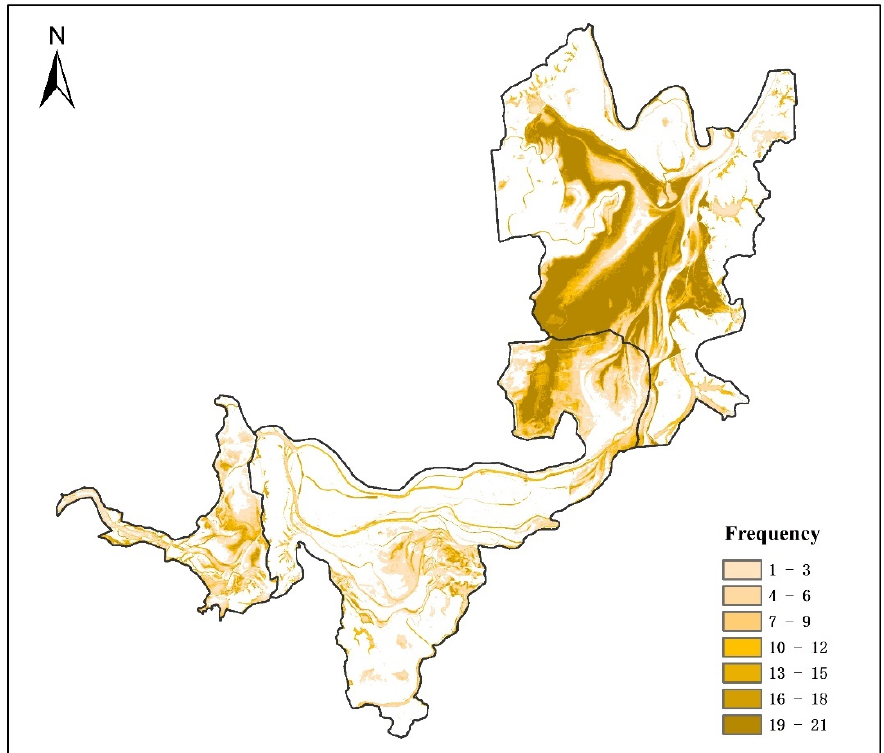
Figure 9. The spatial characteristics of seven levels’ frequencies.